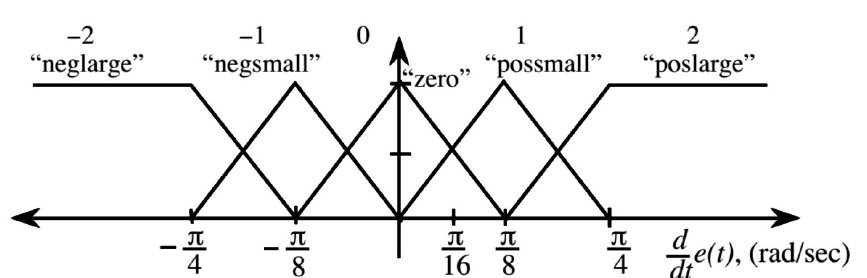
Figure 5. The fuzzy sets for k p .